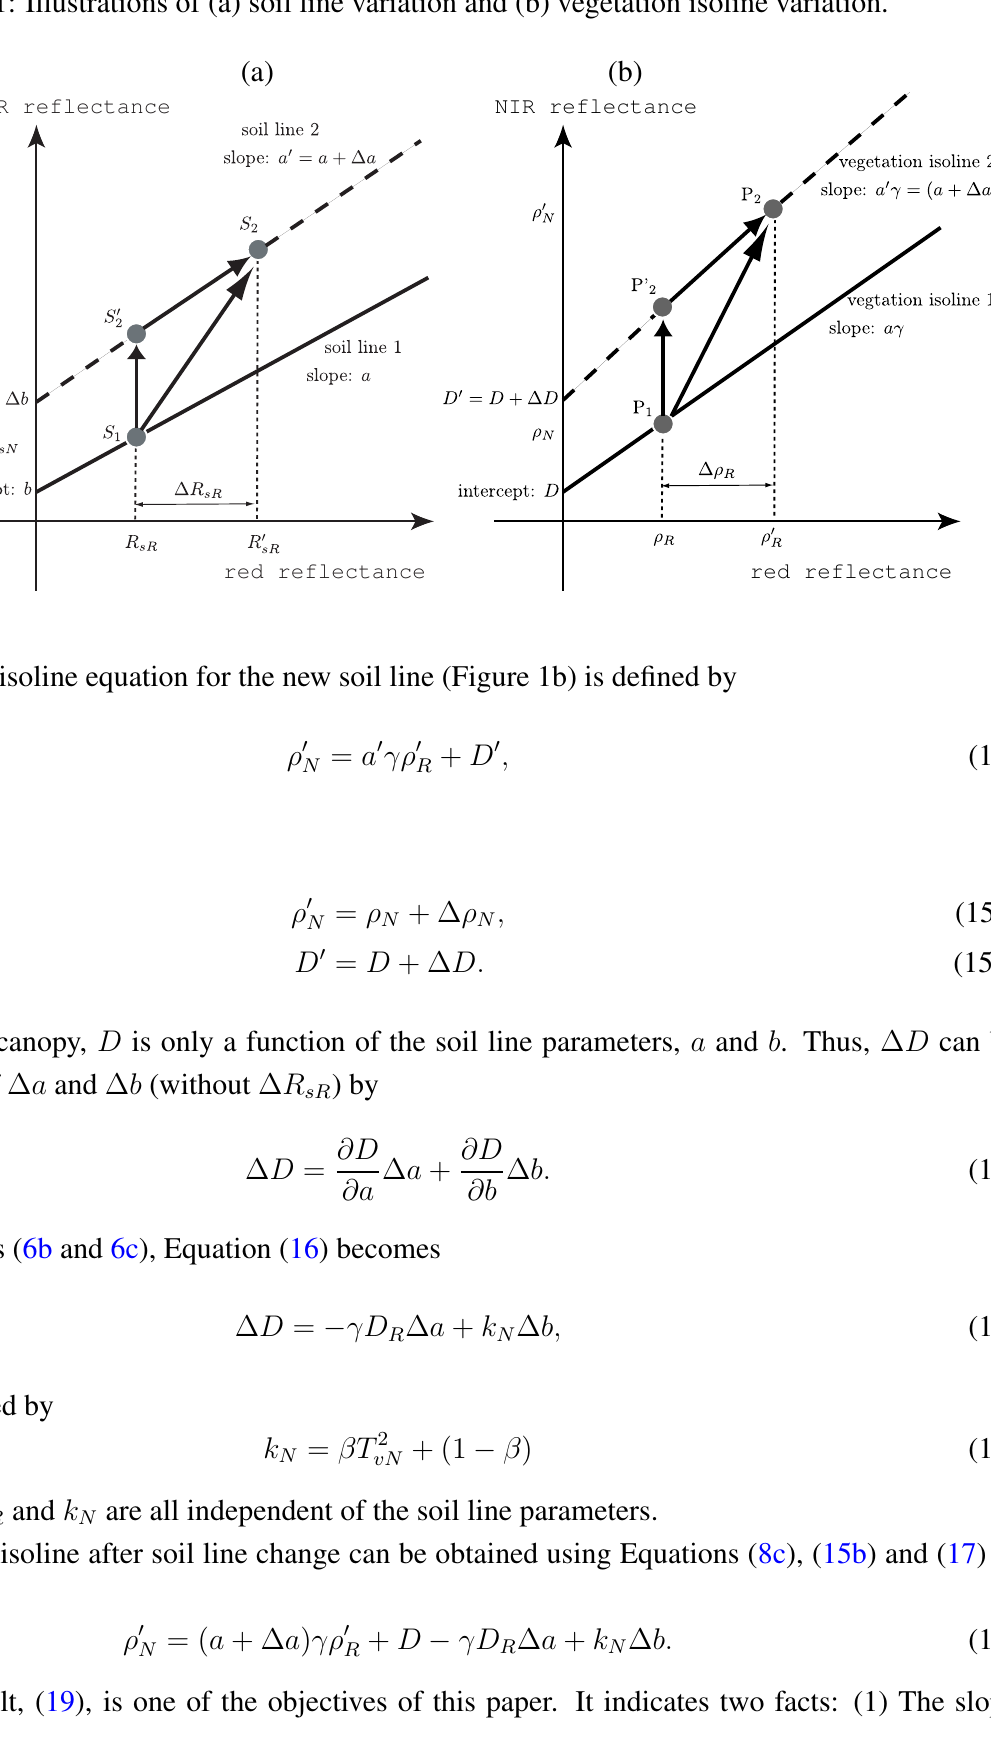
Figure 1: Illustrations of (a) soil line variation and (b) vegetation isoline